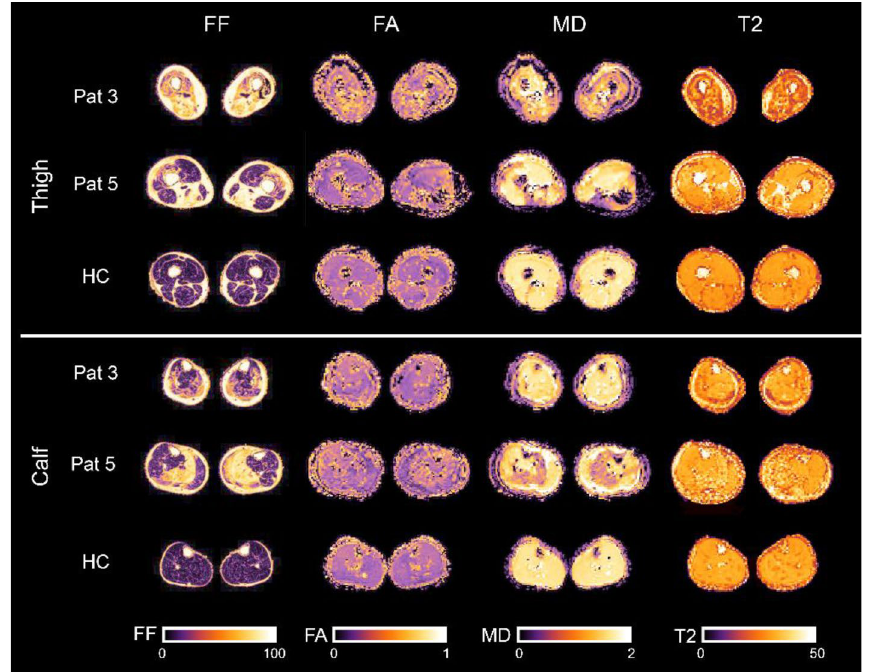
Figure 1. Example images of the applied MRI sequences. mDixon fat fraction (FF), fractional anisotropy (FA), mean diffusivity (MD) and T2 maps for thigh and calf muscles of two representative LGMD patients, and a healthy control (HC).